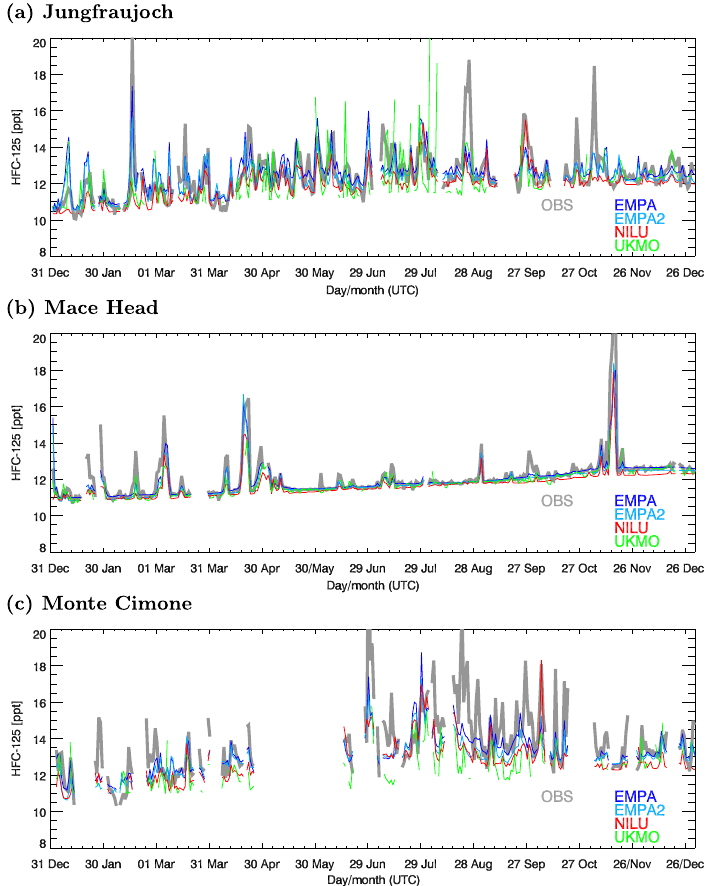
Figure 2. Prior simulated HFC-125 mole fractions (colour lines) overlaid over observations (thick grey line) at the three sites Jungfraujoch, Mace Head, and Monte